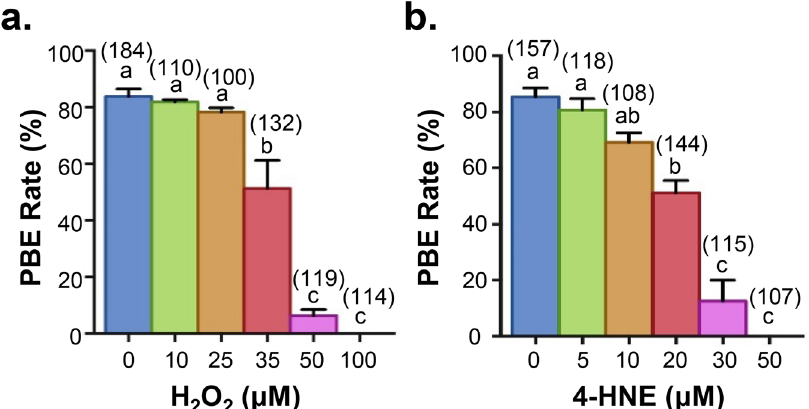
Figure 3. Acute exposure to H 2 O 2 and 4-HNE at GV stage causes a dose-dependent decrease in meiotic completion during IVM. Oocytes at GV stage were treated with either H 2 O 2 for 1 h or 4-HNE for 2 h prior to IVM for 16 h. MII oocytes were identified by the presence of a polar body. ( a ) A dose-dependent decrease in polar body extrusion (PBE) was observed after H 2 O 2 ( p ≤ 0.0011) and ( b ) 4-HNE ( p ≤ 0.0013) treatments. Error bars represent SEM. IVM experiments were performed with five biological replicates with each replicate containing between 20–50 oocytes pooled from a minimum of three